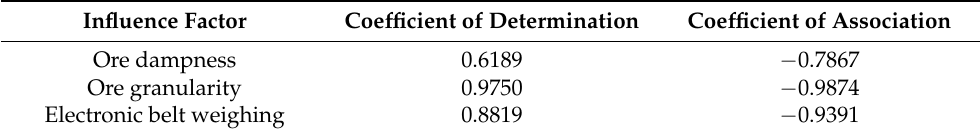
Table 1. Determination and correlation coefficients of the regression model output.